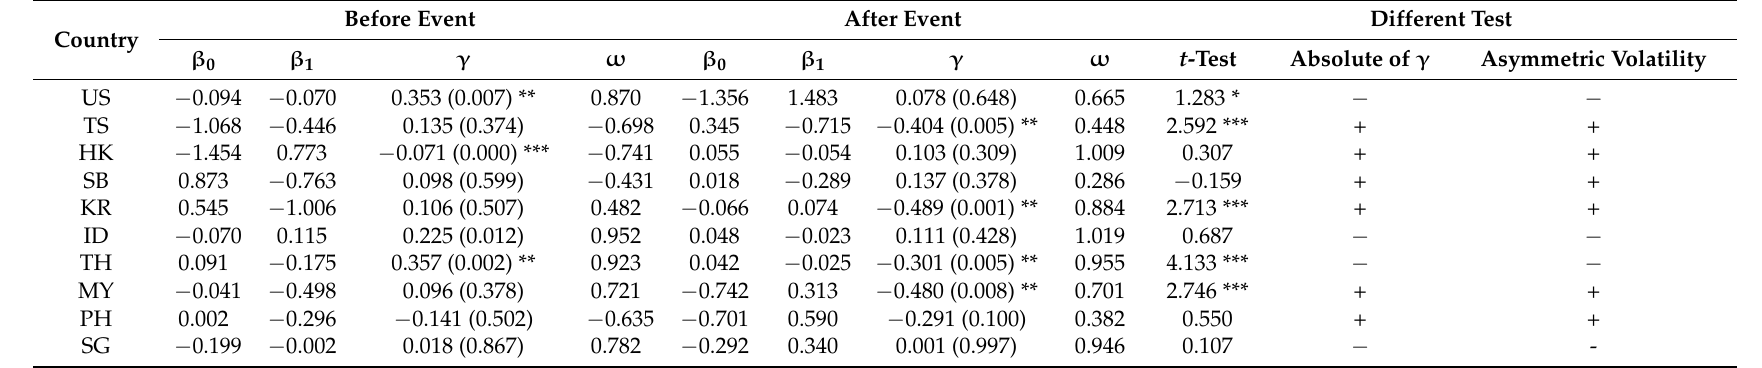
Table 12. The EGARCH model results: Japan’s 3.11 earthquake.